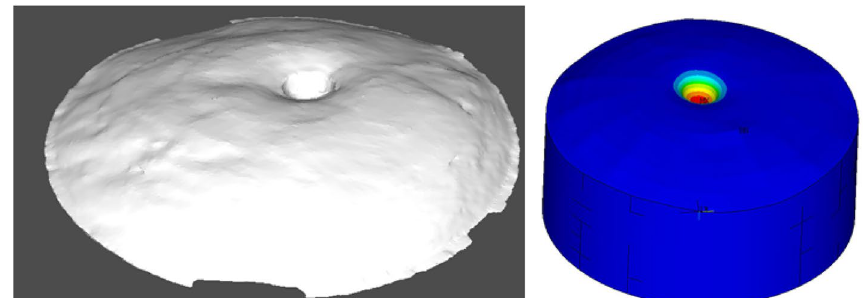
Fig. 11 Comparison of actual indentation with simulated